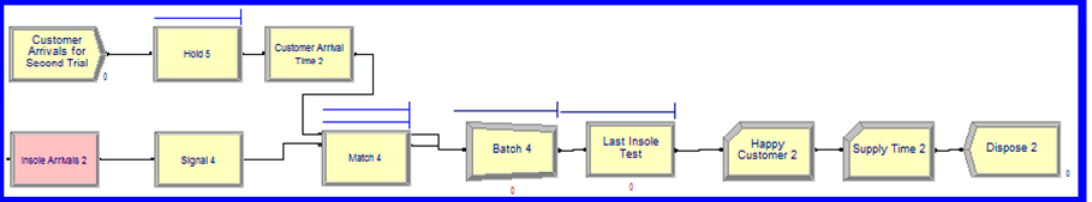
Figure 12. Second testing of insole in the office of orthopedist.